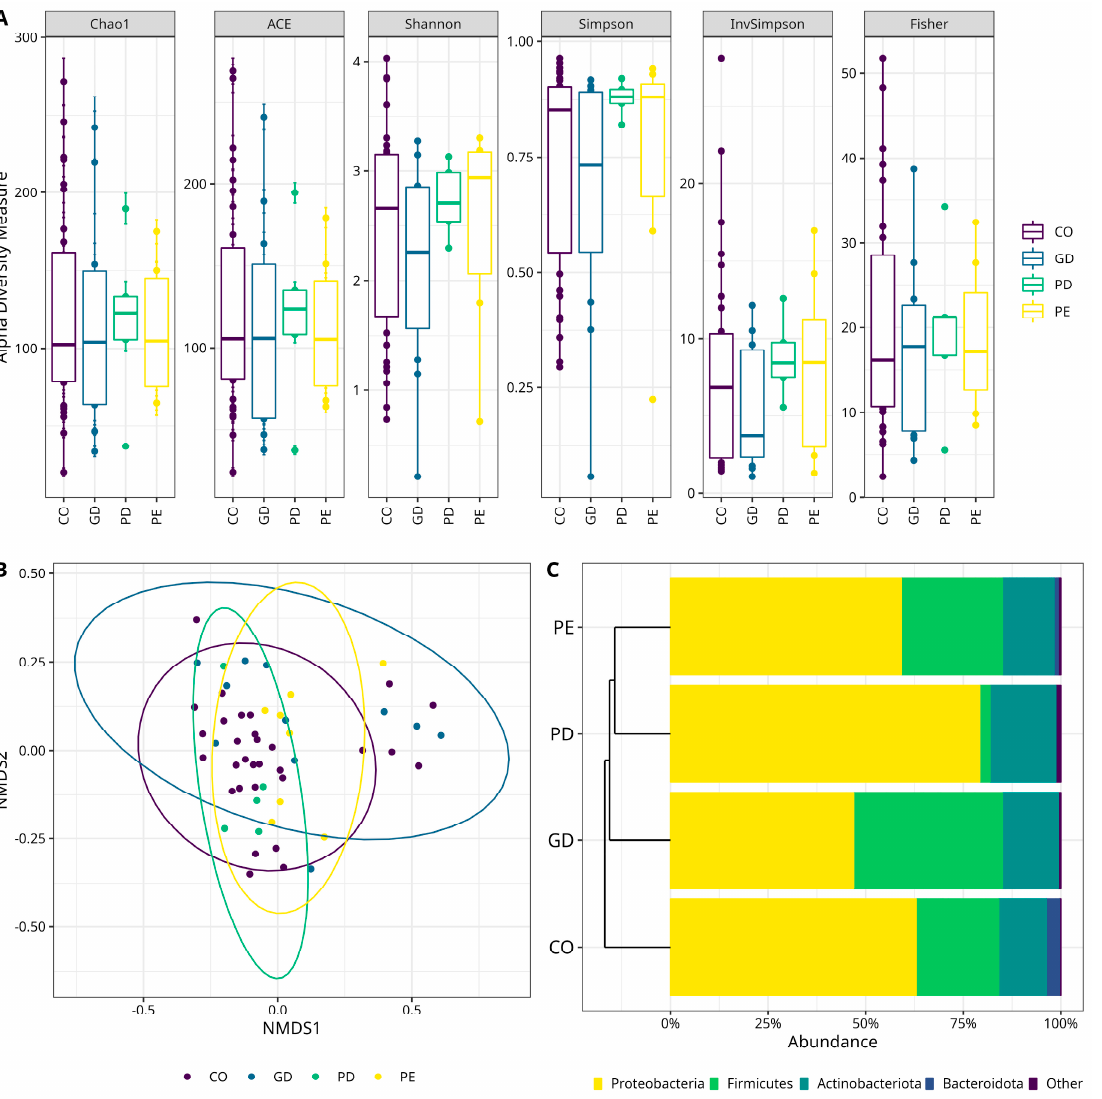
Figure 1. Characterization of the bacterial diversity in the different studied samples. ( A ) Alpha diversity box plots. The Y-axes indicate the values for the species richness indexes (Chao1, ACE),